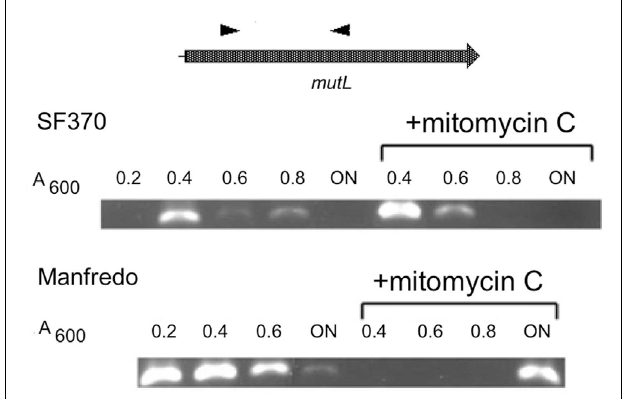
FIGURE 5 | Manfredo mutL mRNA is constitutively expressed under normal growth. Strains Manfredo and SF370 were grown to increasing cell densities [ A 600 = 0.2–0.8 or overnight (ON)].The mRNA was harvested from the cells, converted into cDNA, and the mutL region amplified using primers positioned as shown. For mitomycin C induction, cells were grown to A 600 = 0.2 before mitomycin C was added. In SF370, mutL mRNA was transcribed only early in logarithmic phase and then quickly diminished, following the pattern of SpyCIM1 excision and re-integration (Scott et al., 2008). Mitomycin C induction briefly increased the presence of this mRNA. Strain Manfredo, by contrast, expressed this mRNA constitutively throughout logarithmic growth, and small amounts were detectable still after ON incubation. Mitomycin C treatment inhibited expression of the mRNA during logarithmic growth but greatly enhanced its presence after ON